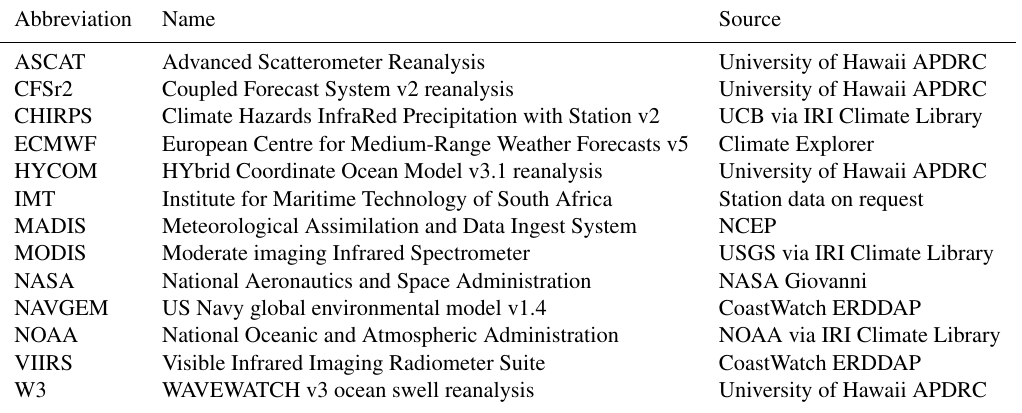
Table 1. Abbreviations and dataset attributes.